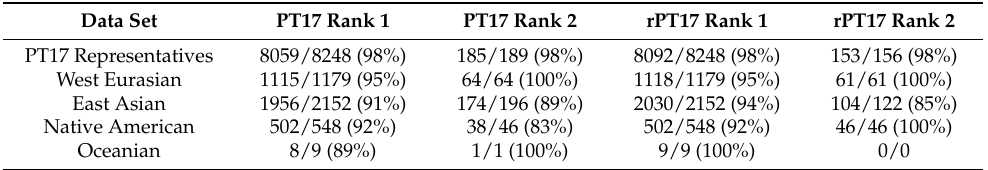
Table 3. Coverage of true haplogroup by CR estimates.